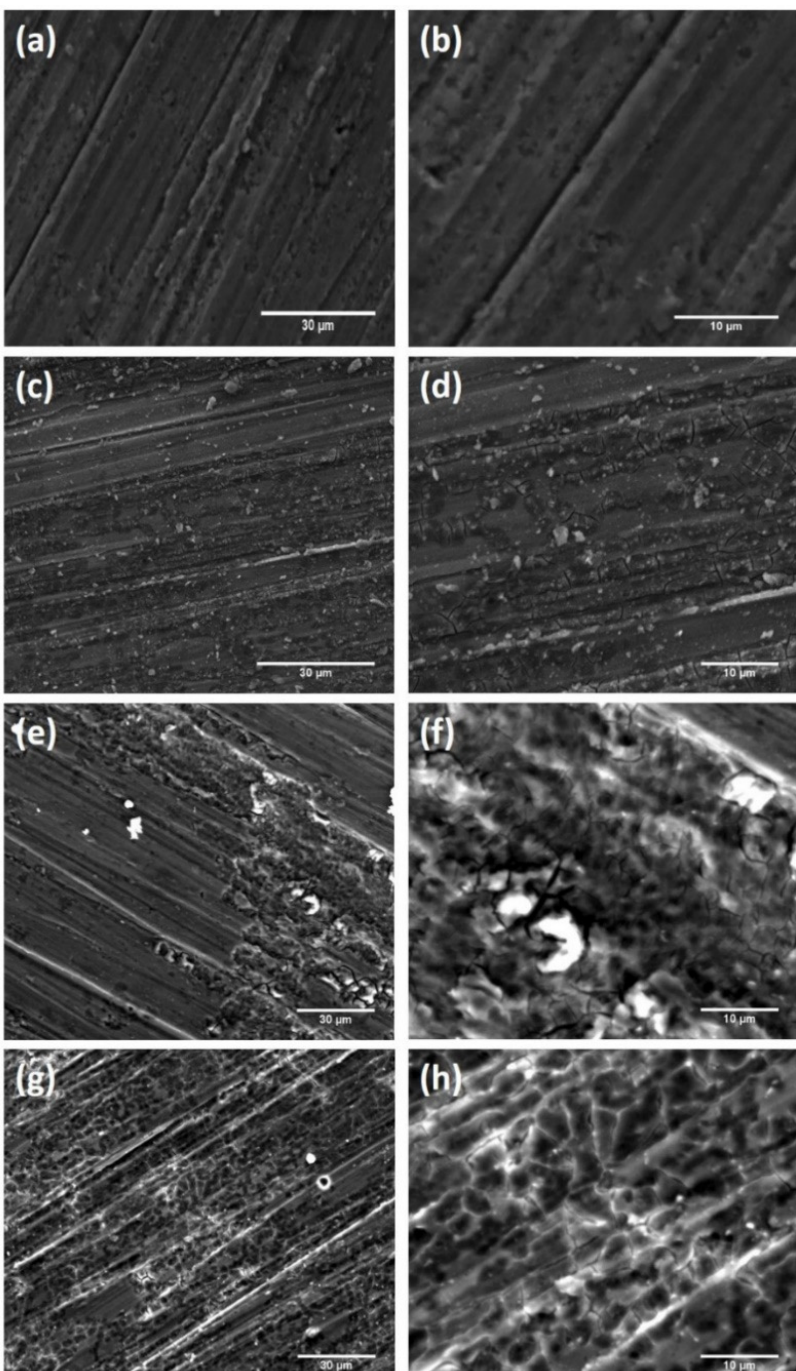
Figure 4. SEM images of ( a , b ) uncoated Mg, ( c , d ) EPD-GO-A coating, ( e , f ) EPD-GO-E coating, and ( g , h ) EPD-GO-W coating.